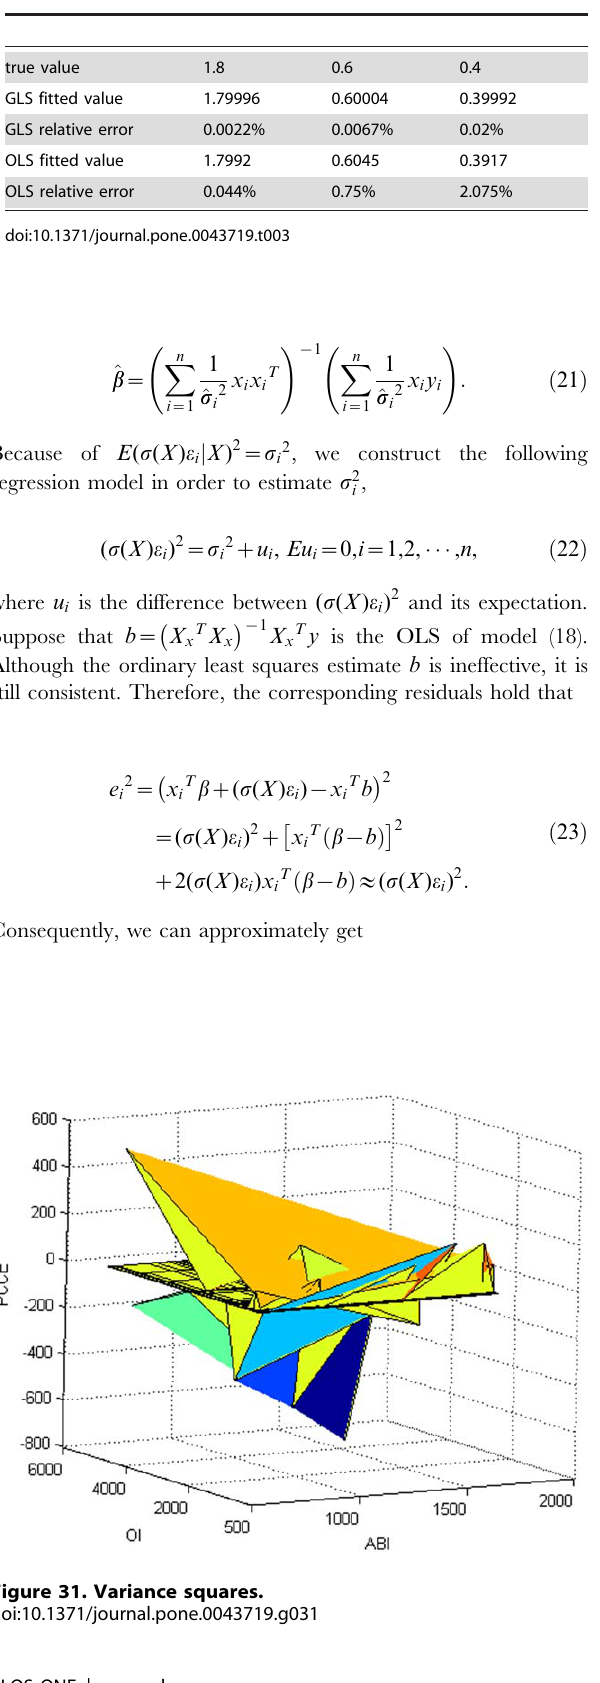
Table 4. The data of PCCE, ABI and OI for regions in China in